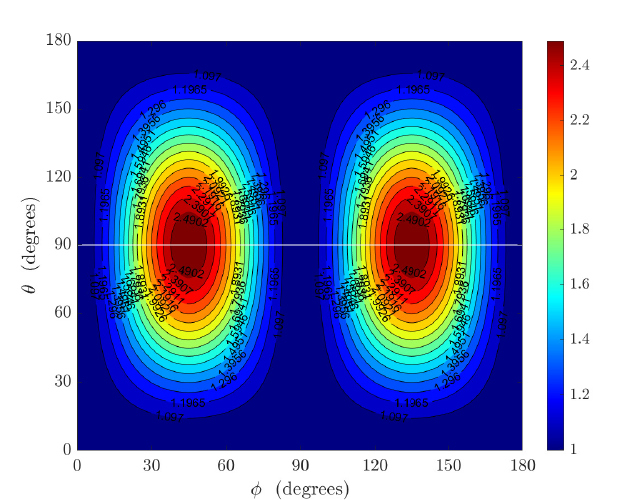
Figure 4. Plot of the performance ratio r θ versus the polar angle and azimuth angle for σ ψ =